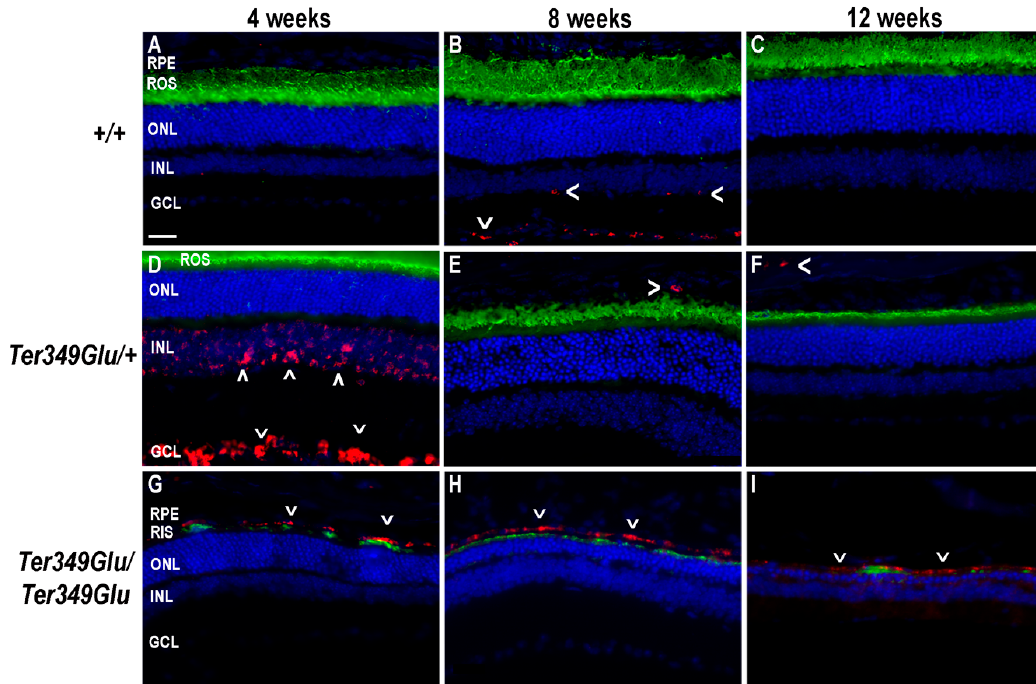
Figure 6. The JAK/STAT antagonist SOCS3 is expressed in Ter349Glu rhodopsin knock-in mouse retina. Using fluorescent immunohistochemistry, the expression of SOCS3, an antagonist to the JAK/STAT pathway, was examined in retinas from wild-type (WT, +/+, A – C ), Ter349Glu heterozygous ( Ter349Glu/+, D – F ), and Ter349Glu homozygous ( Ter349Glu/Ter349Glu , G – I ) mice. Retinal sections were treated for antigen retrieval and labeled for SOCS3 (red) and rhodopsin (green). Nuclei were labeled with DAPI (blue). GCL, ganglion cell layer; arrowheads (<), SOCS3 labeling. Scale bar = 20 μ m.